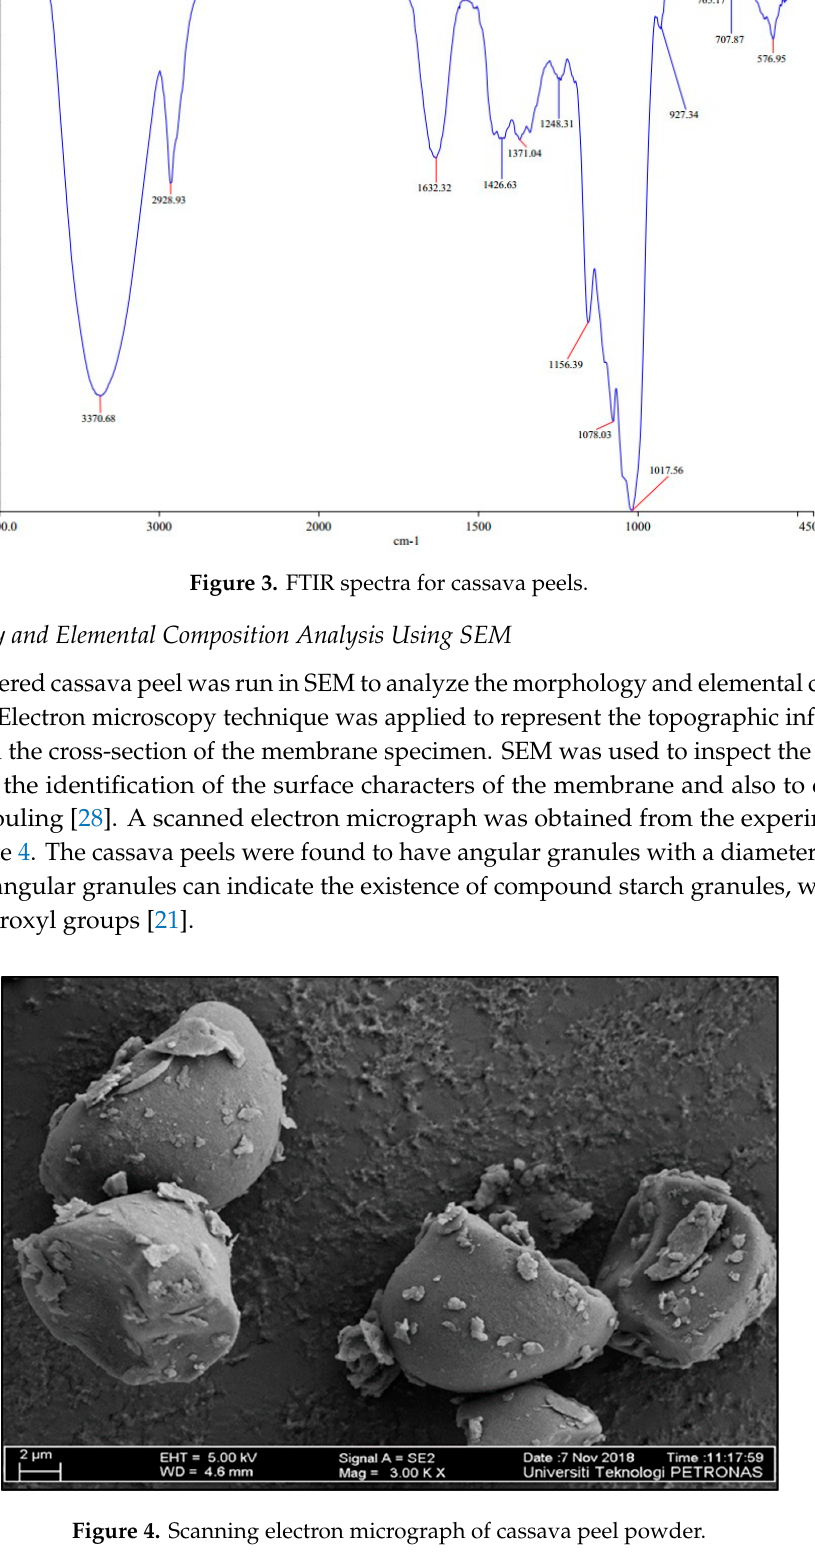
Figure 5. Energy Dispersive X-Ray (EDX) analysis of cassava peel. The elements, compounds, and the corresponding amounts are represented in Table 2. From the analysis, cassava peels contained 71.5 wt % CaCO 3 and 28.12 wt % SiO 2 . Based on the results found from EDX, the elements and compounds found in cassava peels are not toxic for the reservoir environment as they are all naturally occurring chemical compounds.